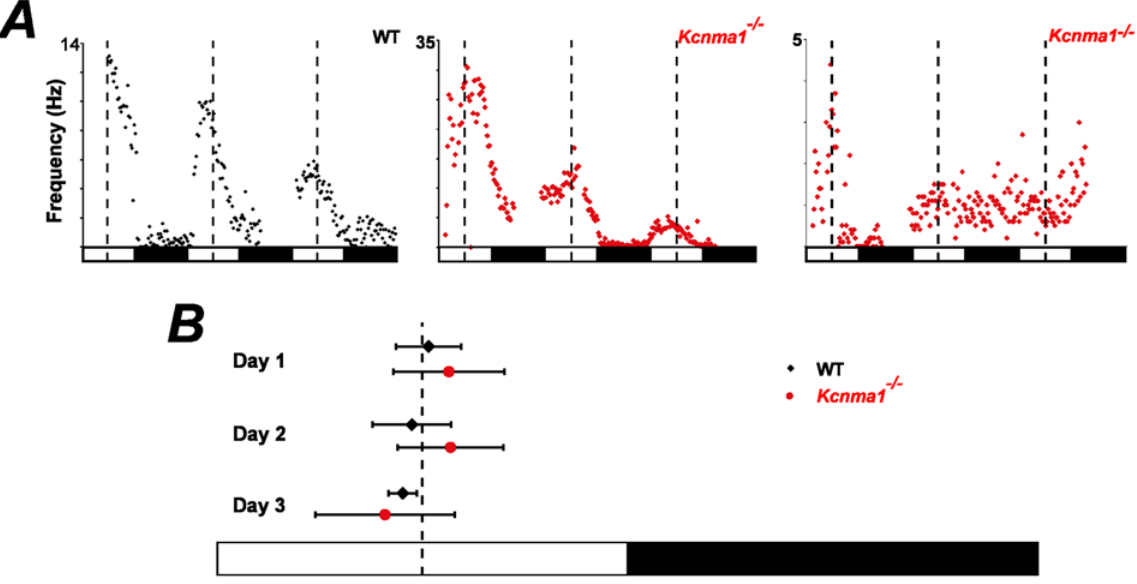
Figure 3. SFR rhythms from 3 circadian cycles from WT and Kcnma1 2 / 2 SCNs. A, Representative recordings over 3 cycles from a rhythmic WT ( left ), a rhythmic Kcnma1 2 / 2 ( middle ), and an arrhythmic Kcnma1 2 / 2 ( right ) channel within the SCN. B, Distribution of daily peaks for WT and Kcnma1 2 / 2 SFR rhythms ( 6 s.d.) on each day of recording.